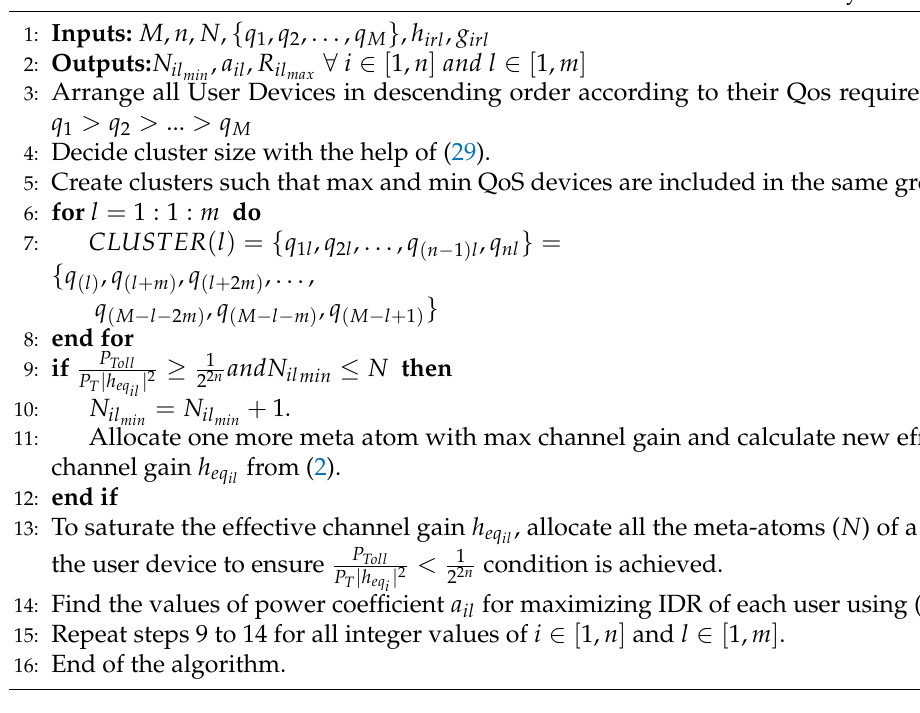
Algorithm 1 Channel Saturation-based Algorithm for Cluster Formation, RIS Allocation, Power Allocation and IDR Maximization in Downlink TDMA-RIS-NOMA